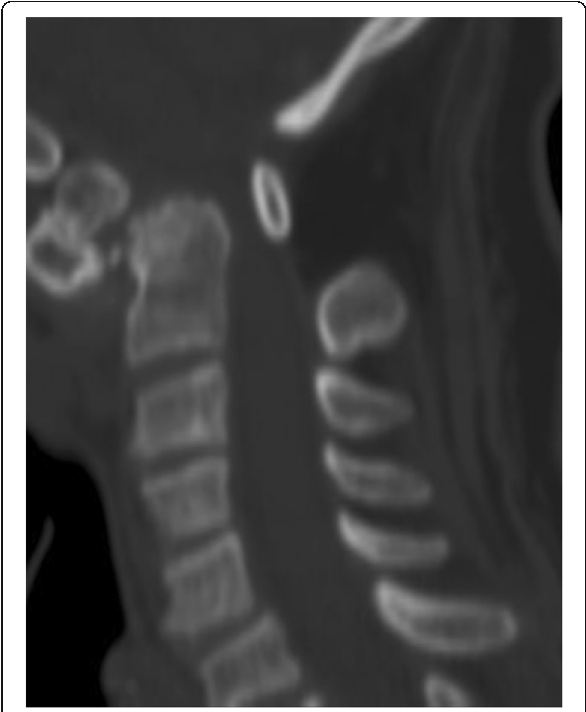
Fig. 14 Sagittal cervical CT of a 68-year-old Down syndrome patient, showing the presence of an os odontoideum with atlanto-axial and atlanto-odontoid luxation; there is severe stenosis of the craniocervical junction, with space conflict in the bulbo-medullary junction